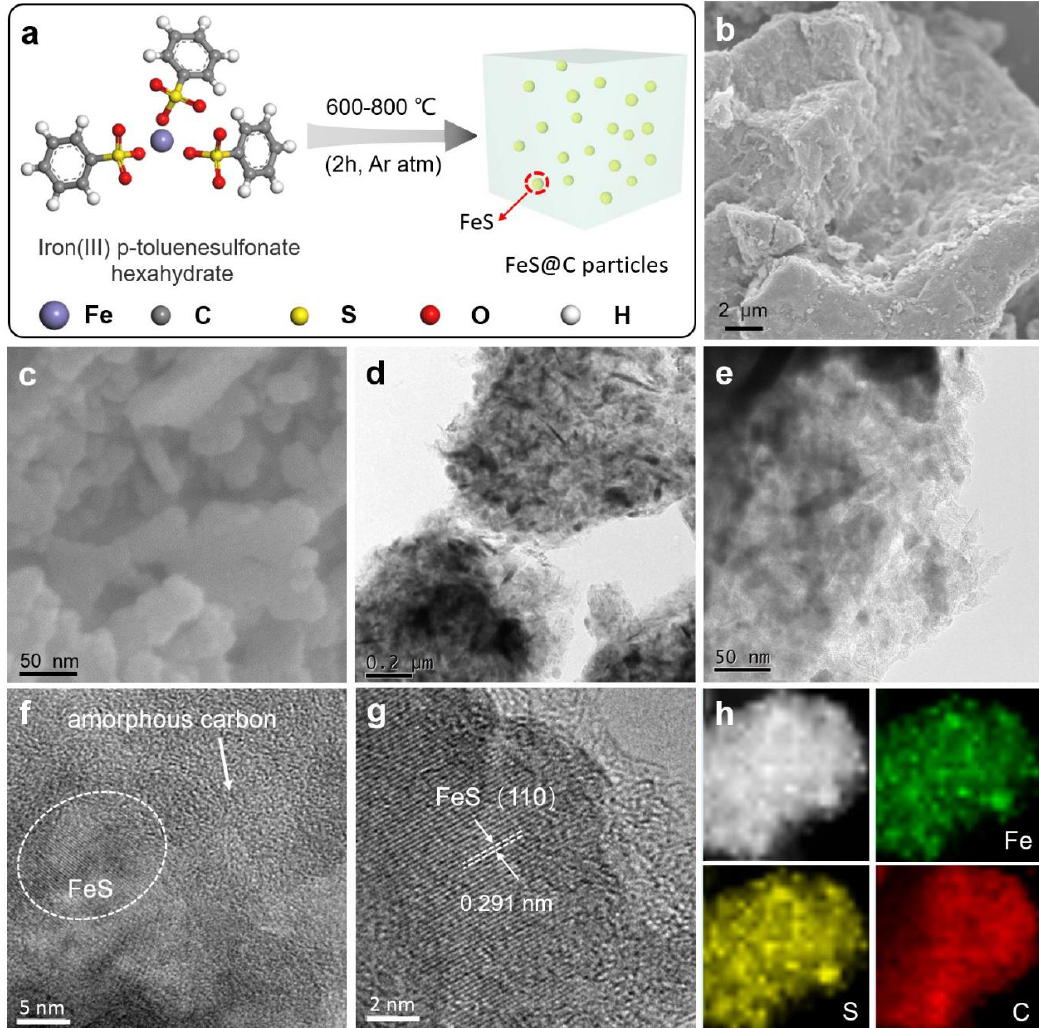
Figure 1. ( a ) Schematic illustration of the preparation process for the FeS@C particles. Iron( Ⅲ ) p-toluenesulfonate hexahydrate was directly calcined at the desired temperatures under Ar atmosphere, obtaining FeS@C particles. The FeS nanoparticles were nanoconfined into a carbon matrix. ( b , c ) SEM images of the FeS@C particles. ( d , e ) TEM images of the FeS@C particles; ( f , g ) high-resolution TEM (HRTEM) images of the FeS@C particles. ( h ) corresponding high-angle annular dark field scanning transmission electron microscopy (HAADF-STEM) and element mapping images of the FeS@C particles.